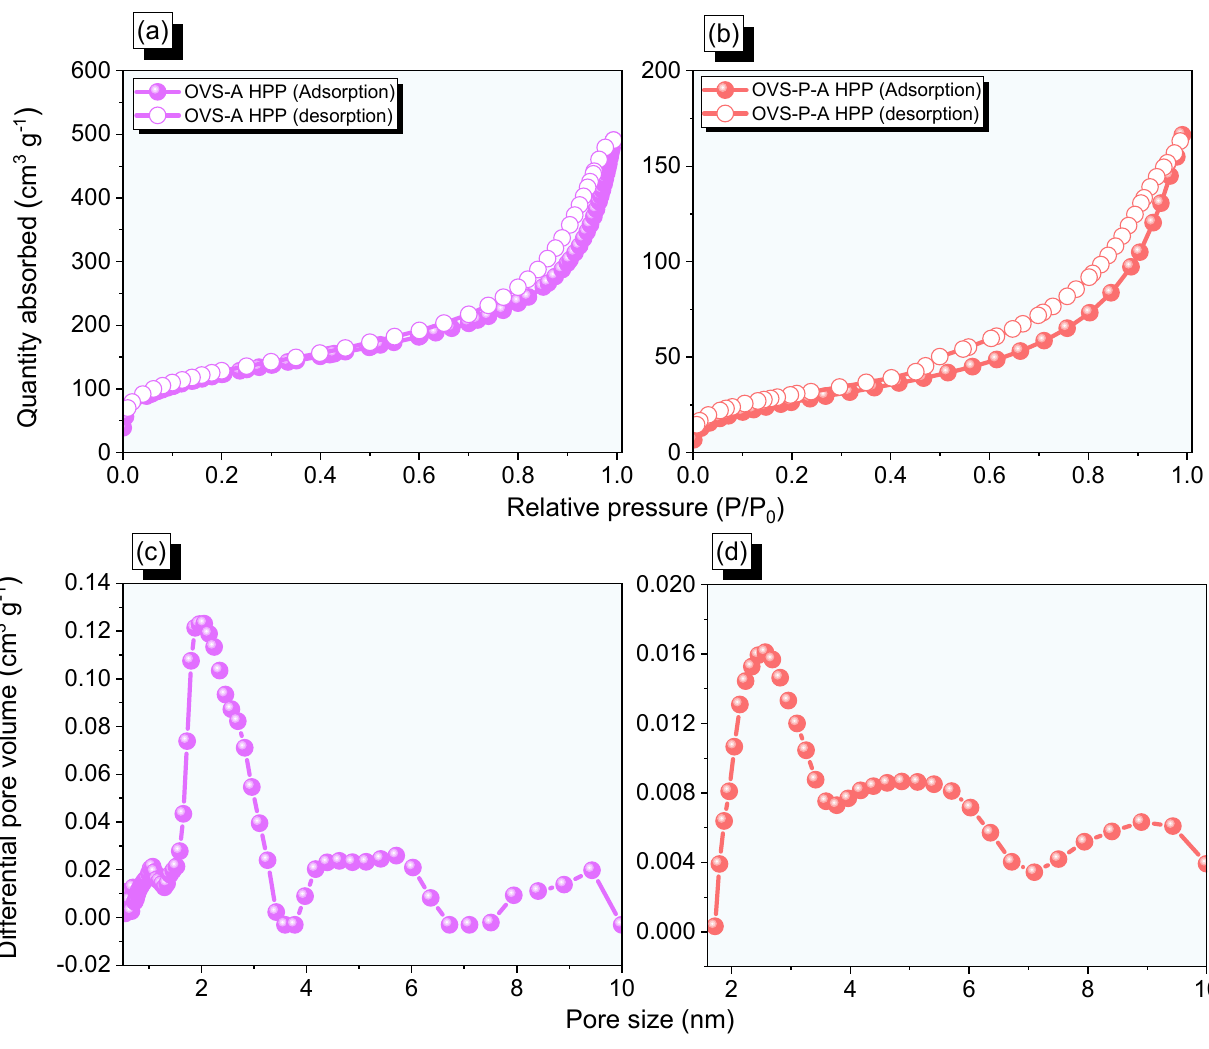
Figure 4. ( a , b ) N 2 isotherms profiles and ( c , d ) pore diameter size of the ( a , c ) OVS-A HPP and ( b , d ) OVS-P-A HPP. The morphological and porous properties of OVS-A HPP and OVS-P-A HPP were investigated by SEM and TEM (Figure S3). The SEM images of OVS-A HPP showed clustered small spheres (Figure S3a), while for OVS-P-A HPP, we observed clustered irregularly shaped columnar and spheres (Figure S3b). The element mapping and energy dispersive X-ray (EDX) analyses of SEM images confirmed the existence of C, N, and O atoms (Figures 5 and 6). The corresponding weight percentages of C, N, and O atoms were found to be 48.3, 16.1, and 36% for OVS-A HPP, and 33.2, 13.3, and 54% for OVS-P-A HPP. Furthermore, the morphology of hybrid porous materials was further confirmed by the TEM images (Figure S3c,d)). These images show small pores, confirming porous structure, and dark and bright patches representing amorphous characteristics in OVS-A HPP and OVS-P-A